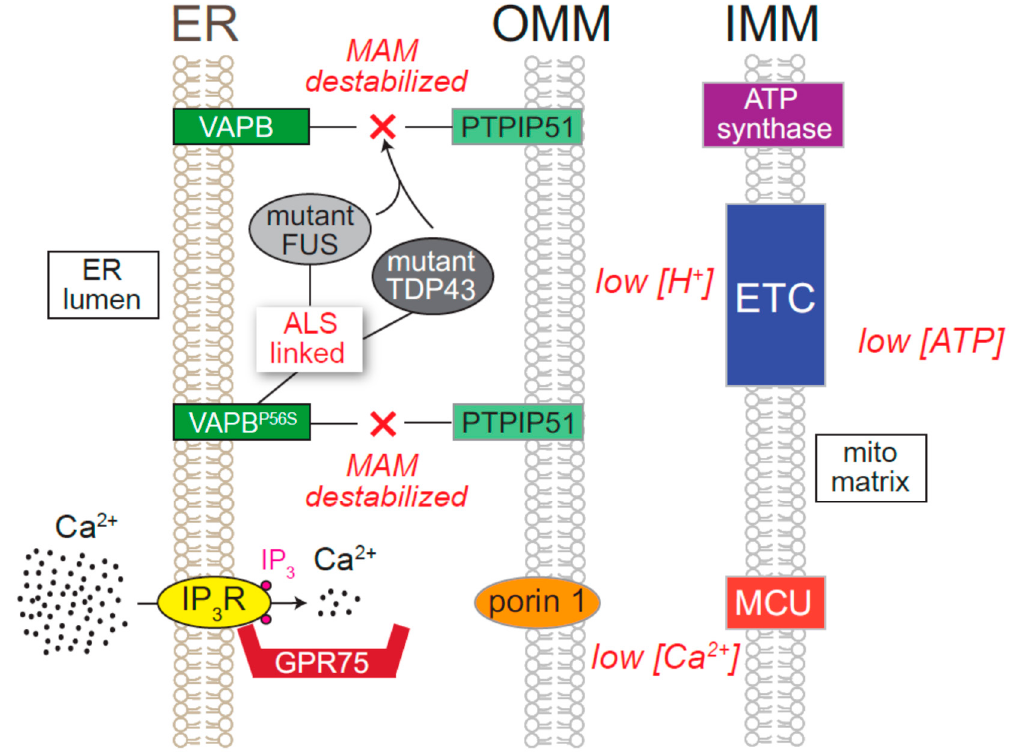
Figure 7. Mechanisms of mitochondria-associated membrane (MAM) dysfunction in amyotrophic lateral sclerosis (ALS). Various ALS-associated mutations lead to breakdown of MAMs. Mutated VAPB (VAPB P56S ) leads to decreased binding with PTPIP51 and mutant FUS and TDP-43 disrupt the VAPB-PTPIP51 interaction, diminishing Ca 2 + transfer from the ER to the mitochondria. Lower Ca 2 + in the mitochondrial matrix results in less oxidative phosphorylation and reduced ATP production.